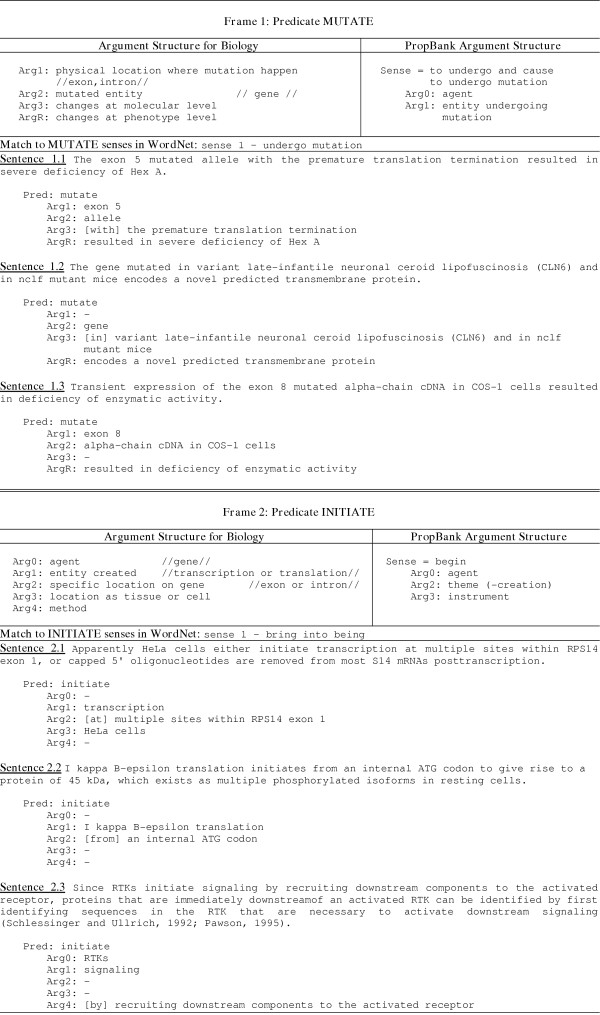
Examples of predicate-argument structures for group A As shown by Frame 1, PAS of mutate provided in PASBio contains more arguments than as suggested by PropBank [22, 23]. Extra arguments responsible for consequences of the event mutate are proposed to be core arguments as they are often seen in sentences from biomedical documents. WordNet [43] sense 1 – undergo mutation is correspond to biological sense we found for mutate. Three sentences are given to illustrate how surface sentences are mapped into PASBio's predicate-argument structure. Frame 2 shows predicate-argument structure of initiate which also belongs to group A – same sense, more arguments as same as predicate mutate. Extra arguments responsible for spatial information of the event intitate are proposed to be core arguments in PASBio, because of their importance from the perspective of biology as discussed in the main text.